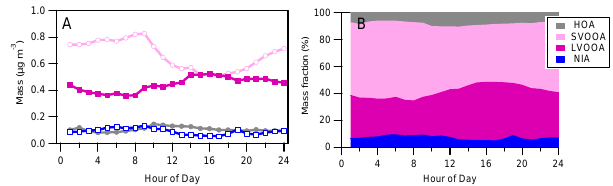
Figure 8. Diurnal cycles of (a) mass concentrations and (b) the mass fractions of the four determined PMF factors. 13